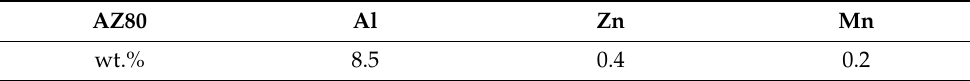
Table 1. The compositions of the WE43 alloys. WE43 Gd Y Nd Zr wt.% Table 2. The compositions of the AZ80 alloys. AZ80 Al Zn Mn